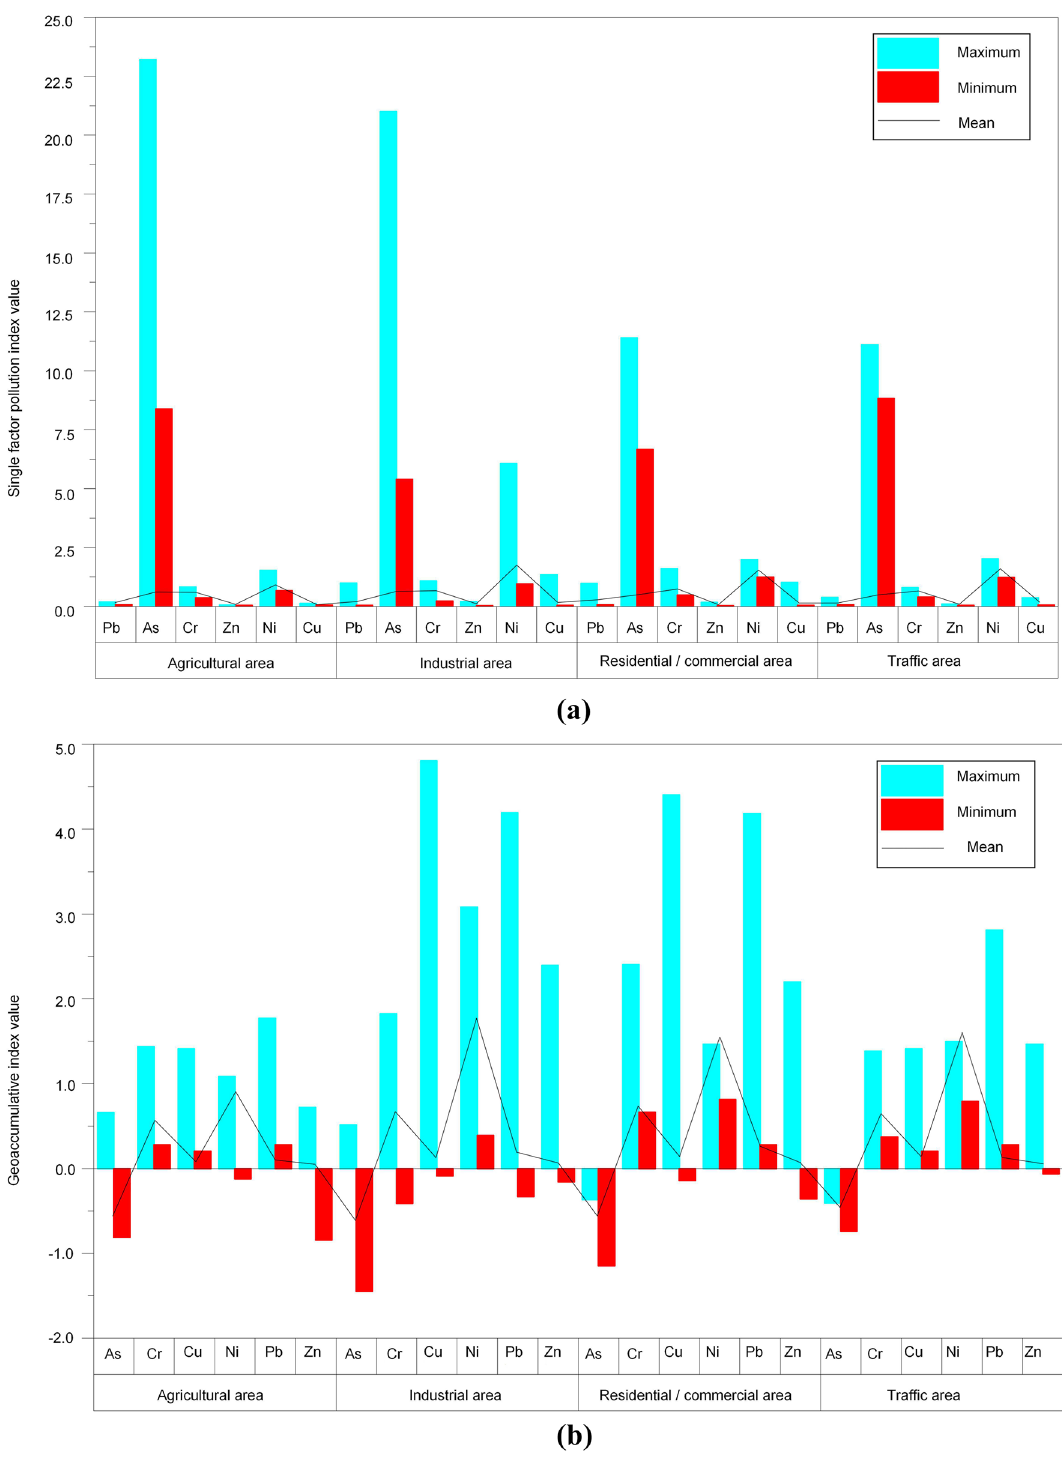
Figure 4. Contamination evaluation of soil heavy metals: (a) Single factor index method; (b) Geoaccumulation index method; the blue bar represents the maximum contamination, the red bar represents the minimum contamination, and the black line represents the mean